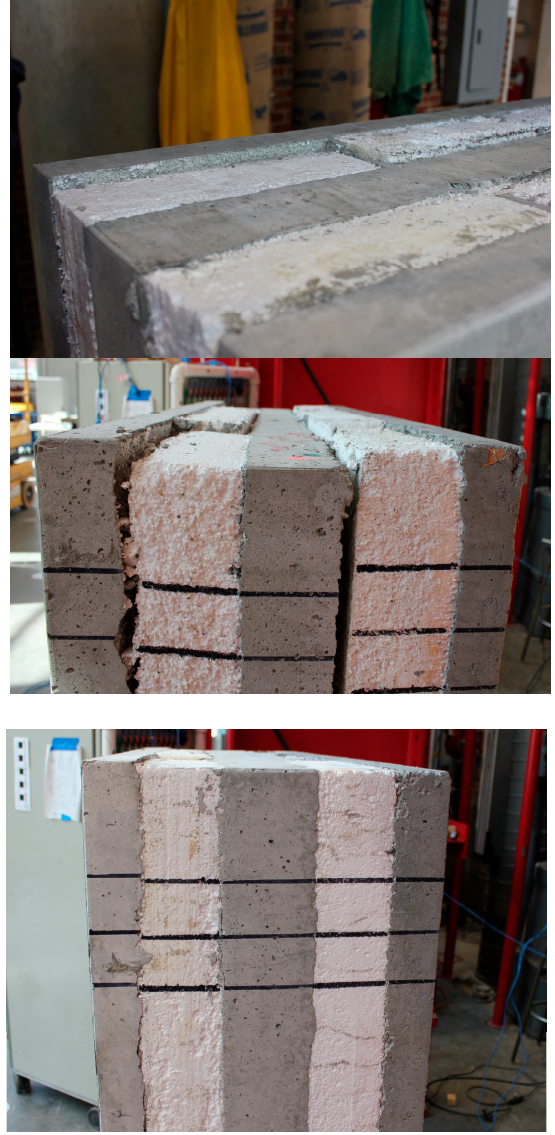
Figure 11. Panels EPS.24.4.MMGRID.1 ( top ), 2 ( middle ), and 3 ( bottom ) after testing. 5.3. Comparison of the EPS.24.2.MMGRID Specimens with 2 (cid:48)(cid:48) Insulation Load vs. average relative displacement graphs of specimens with 2 in (51 mm)